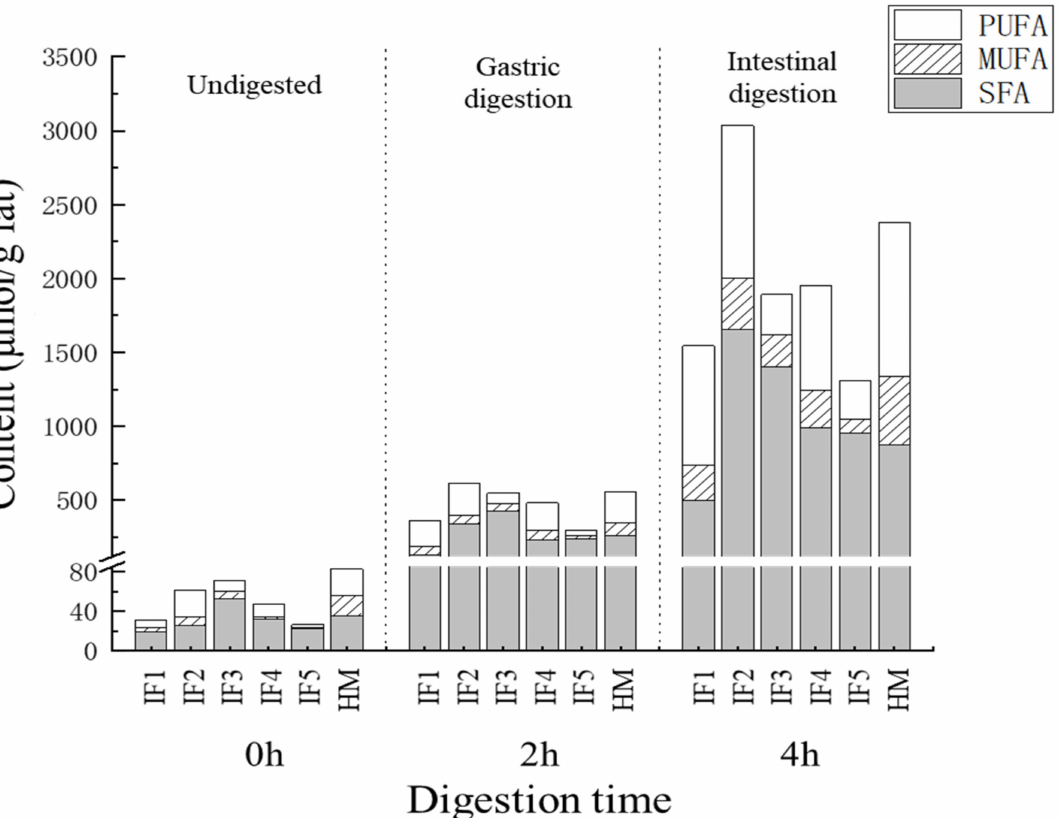
Figure 3. The content and proportion of SFA, MUFA, and PUFA in infant formulas and human milk during digestion. IF1: vegetable oil-based formula; IF2: vegetable oil-based formula with MFGM; IF3: bovine milk/vegetable oil-based formula with cream; IF4 bovine milk/vegetable oil-based formula with cream and soybean phospholipid; IF5: whole fat milk power/vegetable oil-based